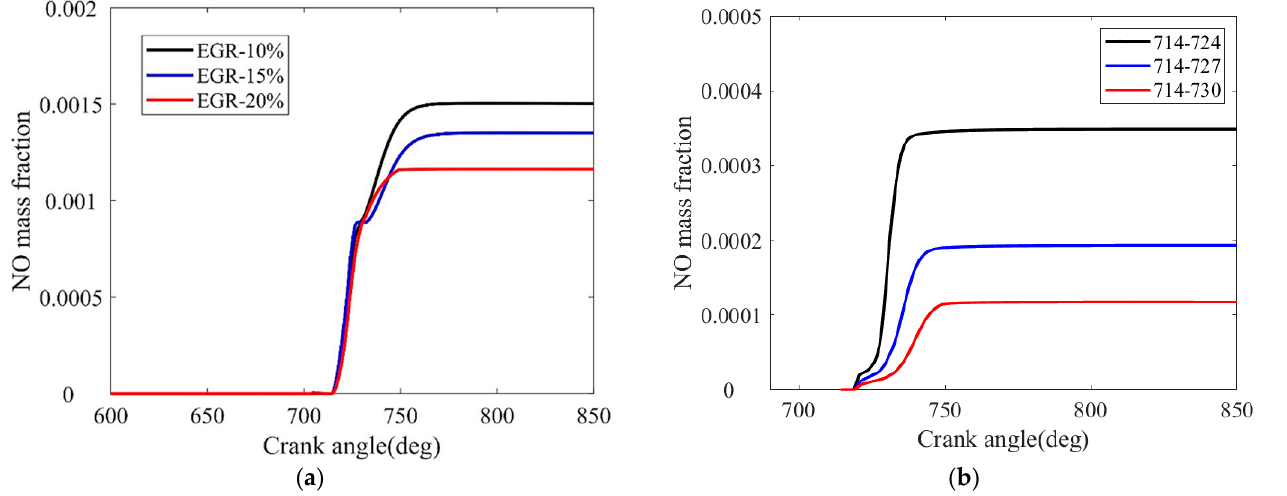
Figure 14. NO emission at different EGR rates and injection durations: ( a ) different EGR rates; ( b ) different injection durations.